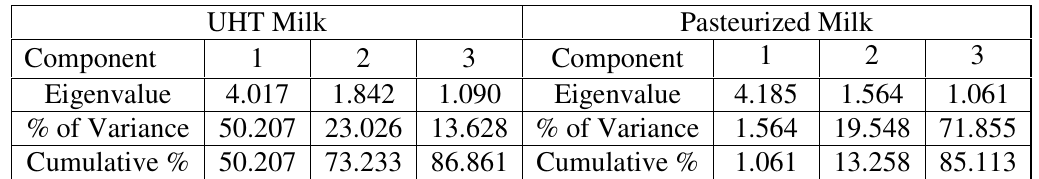
Table 2: Eigenvalue and percentage variance of the PCA analysis of response data